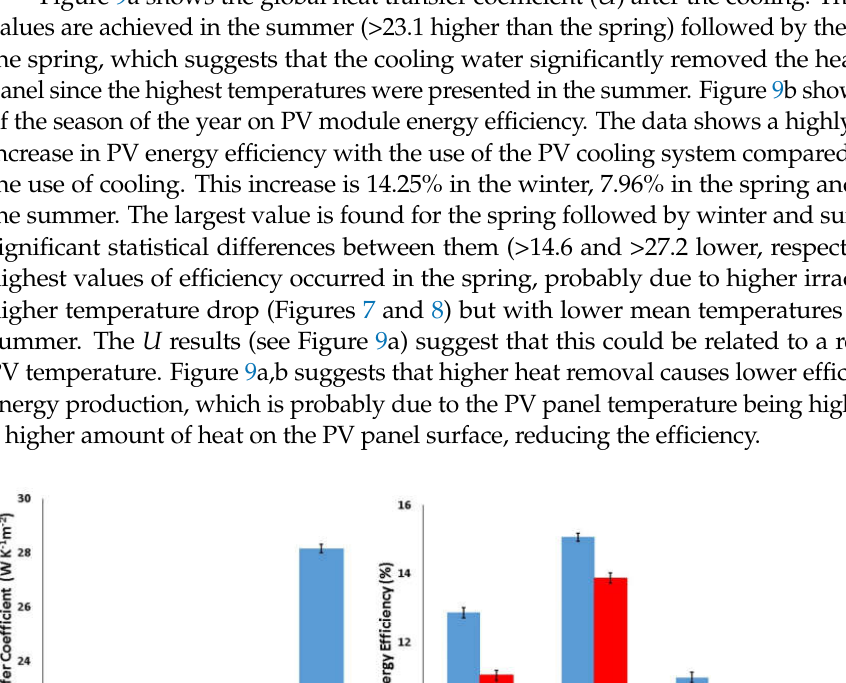
Figure 10. Correlation between initial investment and BWRO capacity. EPC = Engineering, pro- curement and construction. Table 3 shows the total cost ( TC ) in USD m −3 of desalinated water for different tem- peratures in the brackish feedwater at 20, 23, 26 and 30 °C at 5000 mg L −1 with their differ- ent costs and percentages. Specific energy consumption ( SEC ), conservation and mainte- nance ( c & m ), labor ( mp ), management ( m ), and chemicals ( ch ).